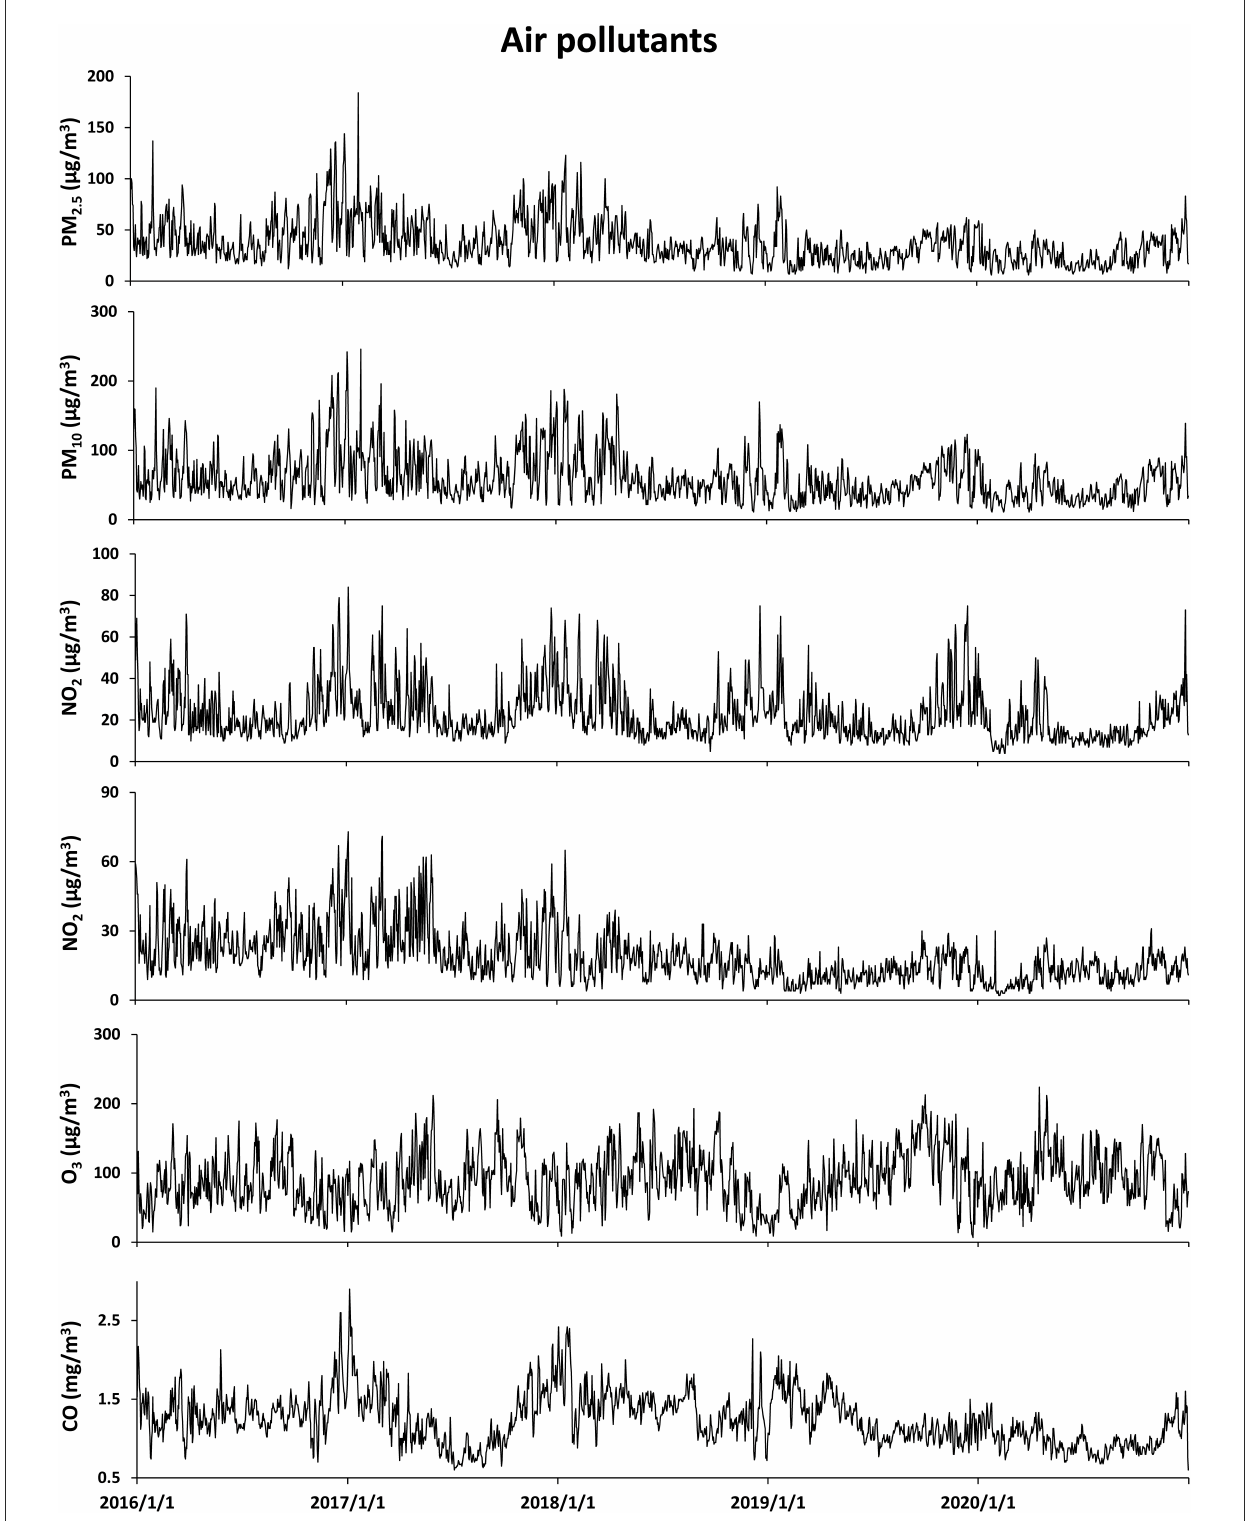
FIGURE1 Data for temporal distributions of air pollutants from 1 January 2016 to 31 December 2020 in